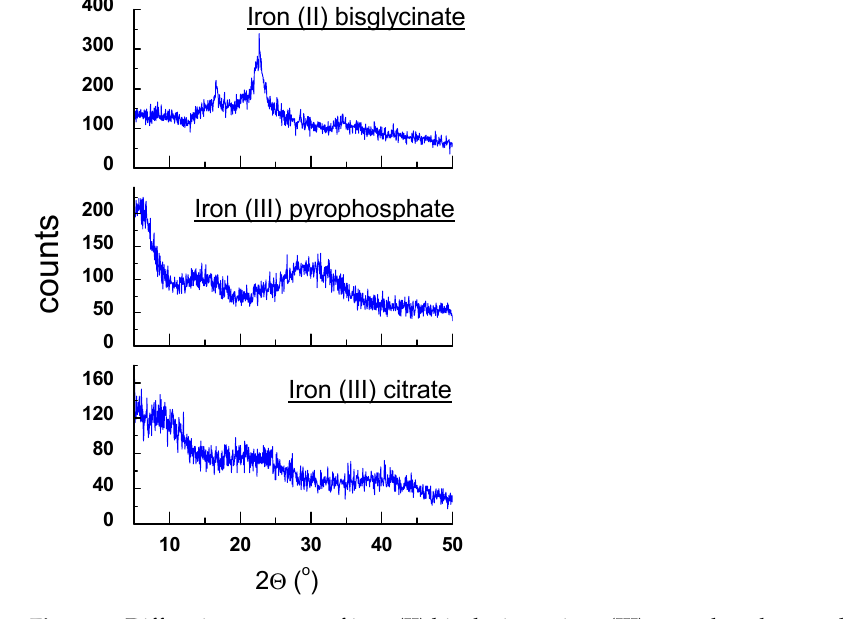
Figure 2. Diffraction patterns of iron (II) bisglycinate, iron (III) pyrophosphate and iron (III) citrate.